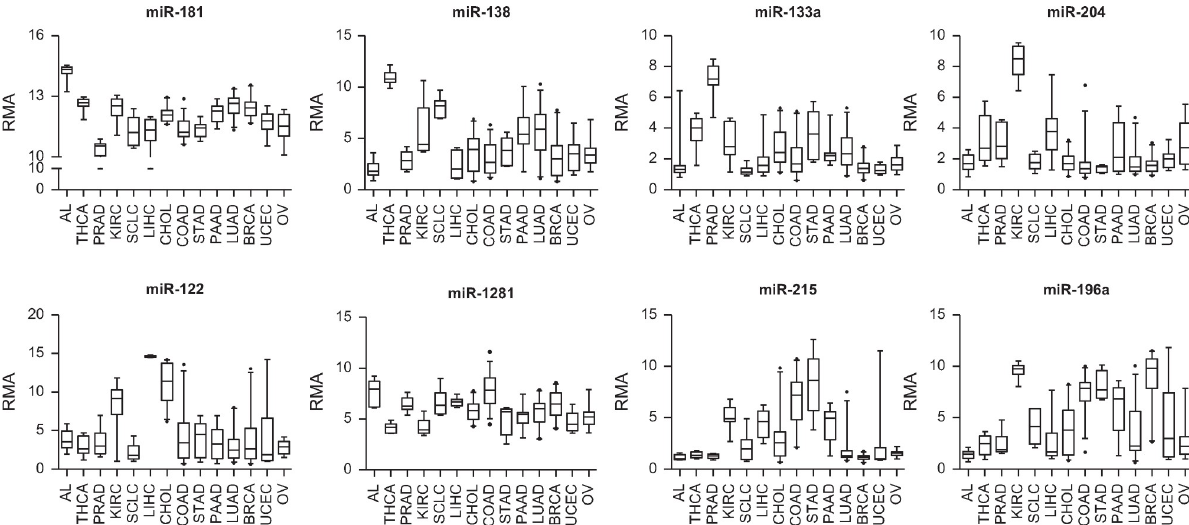
Fig 2. Expression profiles of selective discriminatory microRNAs of each node in the training set. Discriminatory microRNAs were defined as microRNAs differentially expressed between two branches at each node of the decision tree at p < 0.00005. The tissue of origin was assigned by selecting one of the two branches at each node using these discriminatory microRNAs. Acute leukemia (AL), thyroid cancer (THCA), prostate adenocarcinoma (PRAD), renal cell carcinoma (KIRC), small cell lung carcinoma (SCLC), hepatocellular carcinoma (LIHC), cholangiocarcinoma (CHOL), colorectal adenocarcinoma (COAD), gastric adenocarcinoma (STAD), pancreatic adenocarcinoma (PAAD), lung adenocarcinoma (LUAD), breast adenocarcinoma (BRCA), uterine endometrial carcinoma (UCEC), ovarian cancer (OV).